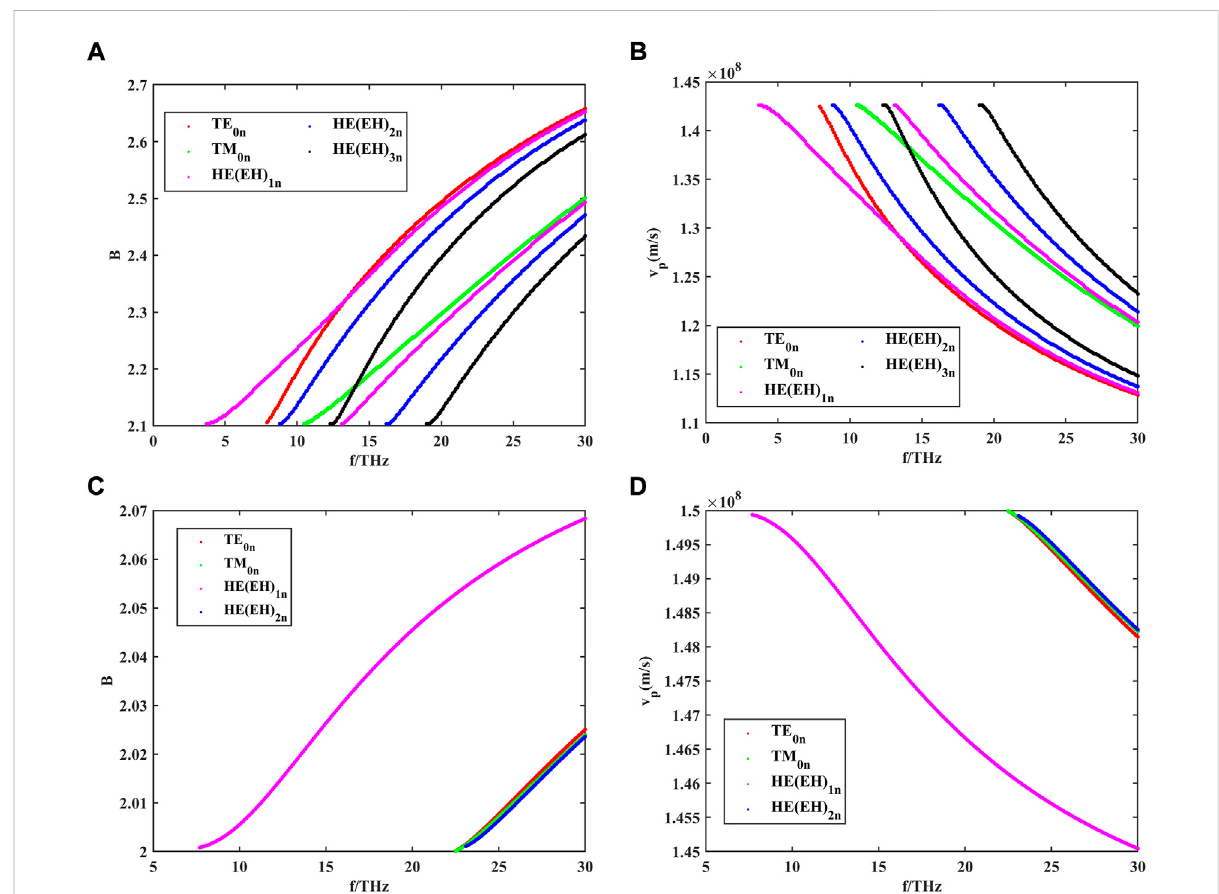
FIGURE 3 (A) Dispersioncurvesofdifferentguidedmodes inthemyelinatednerve fi berswithin thefrequencyrange of0 – 30 THz,where m isthenumber of angular variations; (B) phase velocity of different guided modes in the myelinated nerve fi bers within the frequency range of 0 – 30 THz; (C) dispersion curves of different guided modes in the unmyelinated nerve fi bers within the frequency range of 0 – 30 THz; and (D) phase velocity of different guided modes in the unmyelinated nerve fi bers within the frequency range of 0 – 30